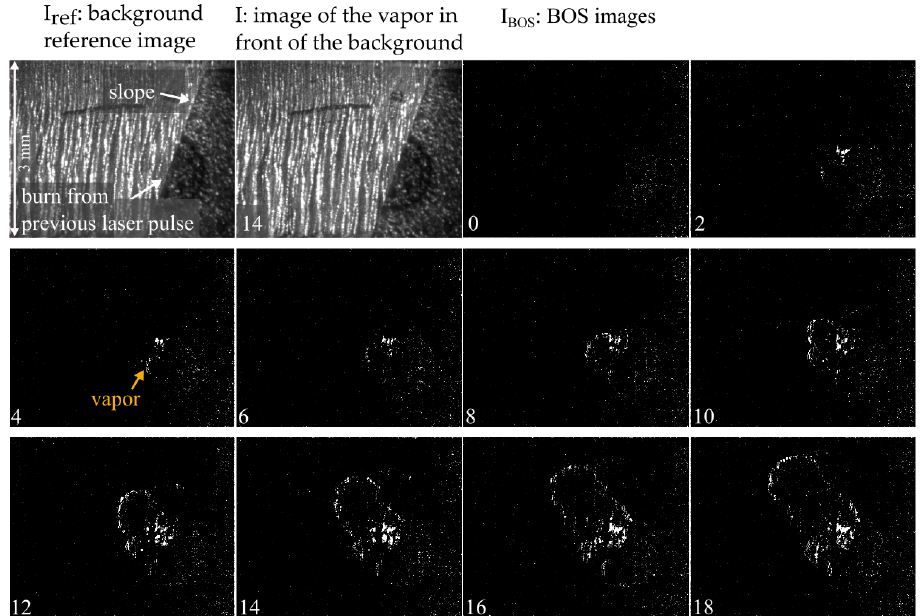
Figure 9. Start of the evaporation when heating the metal front with a processing laser. The expansion of the vapor is not directly visible in the recorded images but becomes visible in the BOS images. The images were captured at a rate of 73,000 fps with an illumination time of 1 µs; every second image is shown here. That means about 27 µs pass between two pictures shown here.